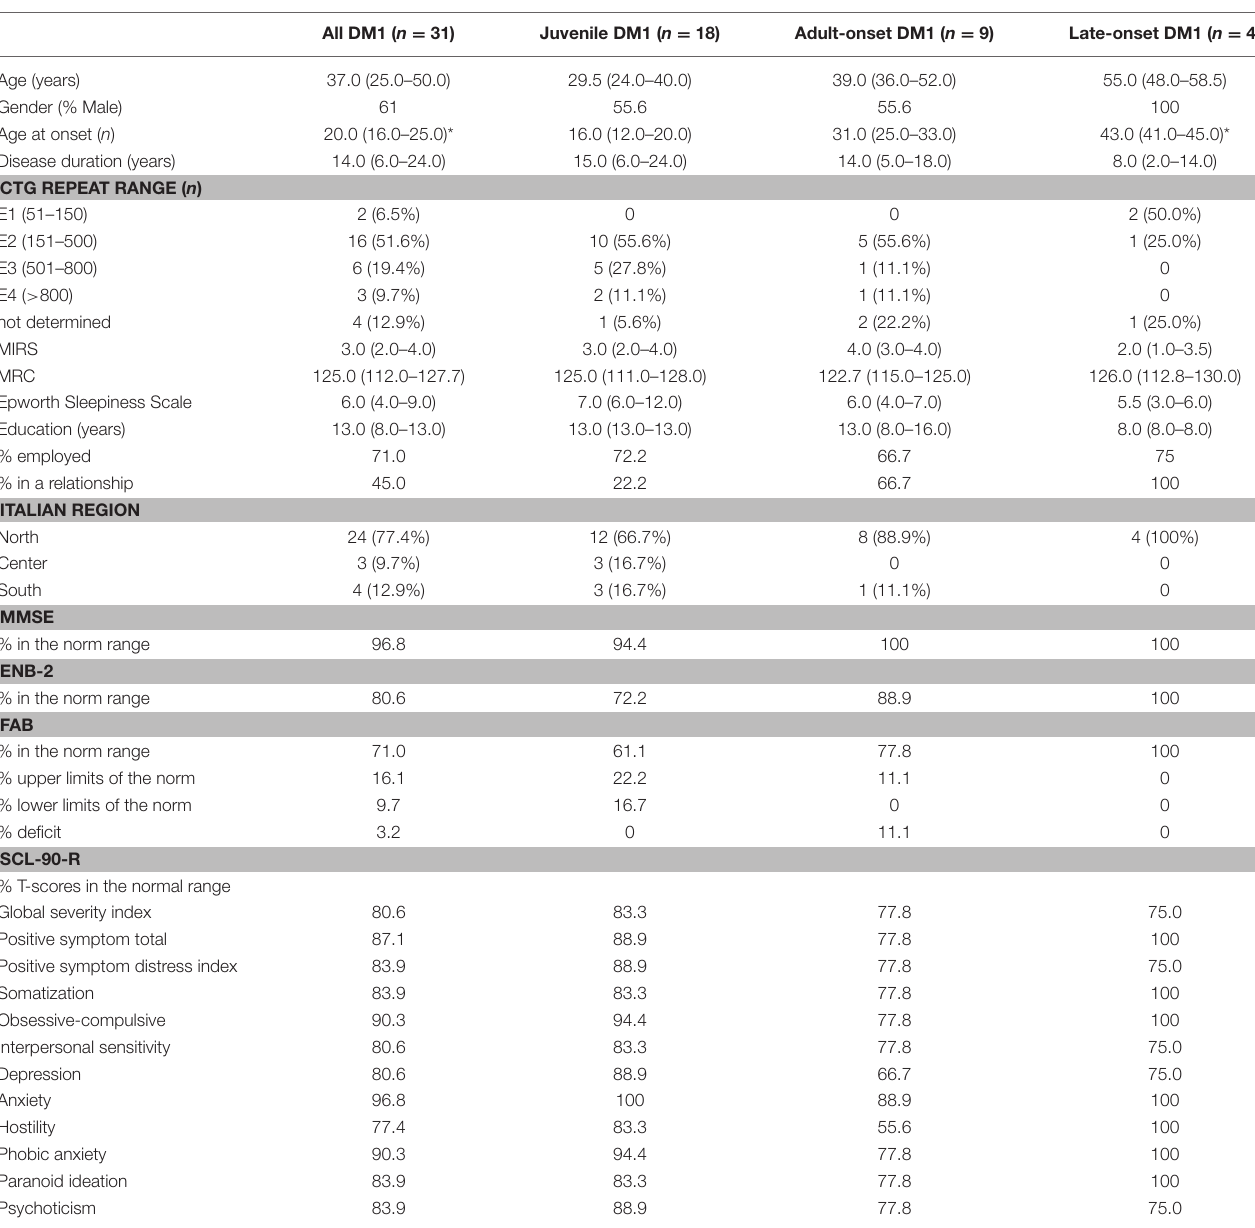
TABLE 2 | Sociodemographic, clinical, and psychological characteristics of DM1